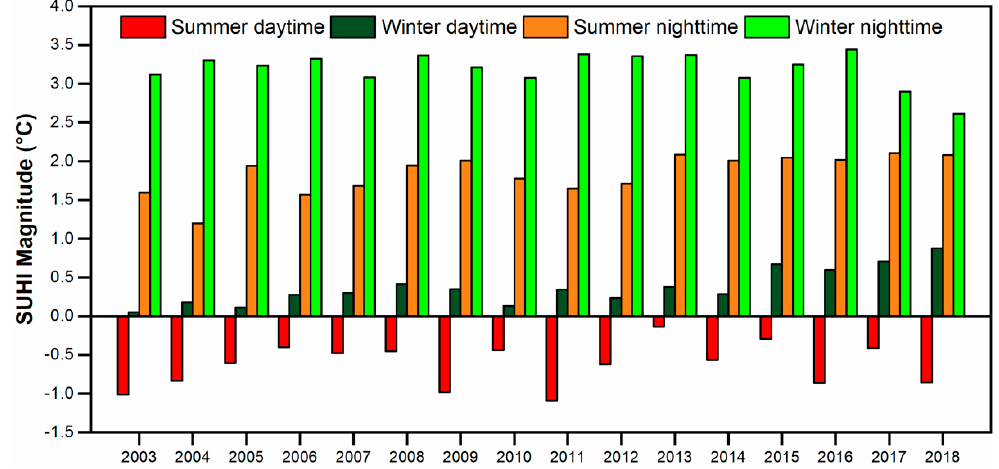
Figure 5. Interannual variation (2003–2018) of the mean SUHI magnitude of Ahmedabad city during daytime and nighttime, in summer and winter.